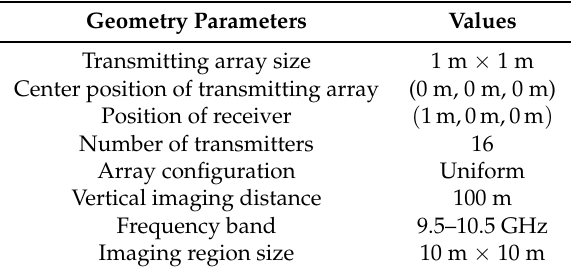
Table 1. Geometry